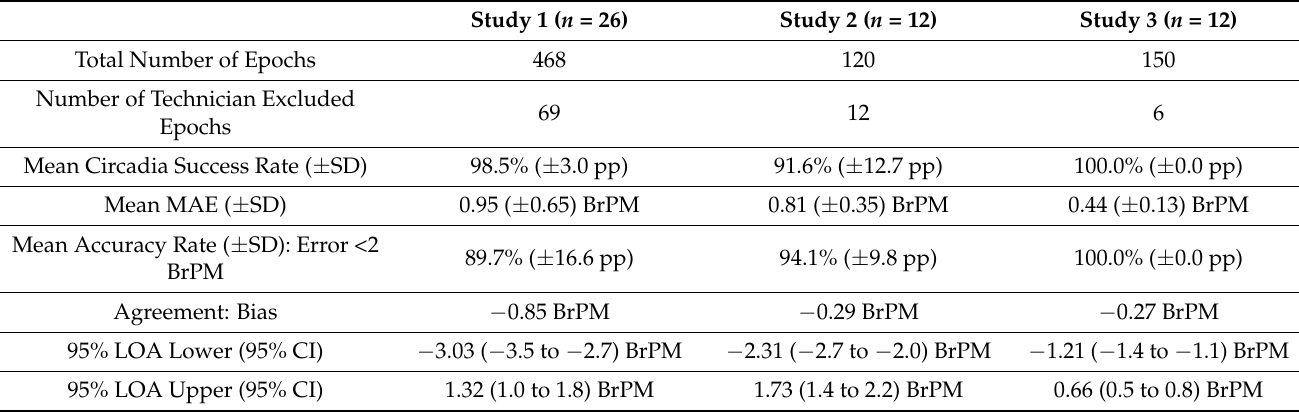
Table 2. Overview of results for Studies 1, 2, and 3. Mean metrics are given across subjects, with standard deviation.